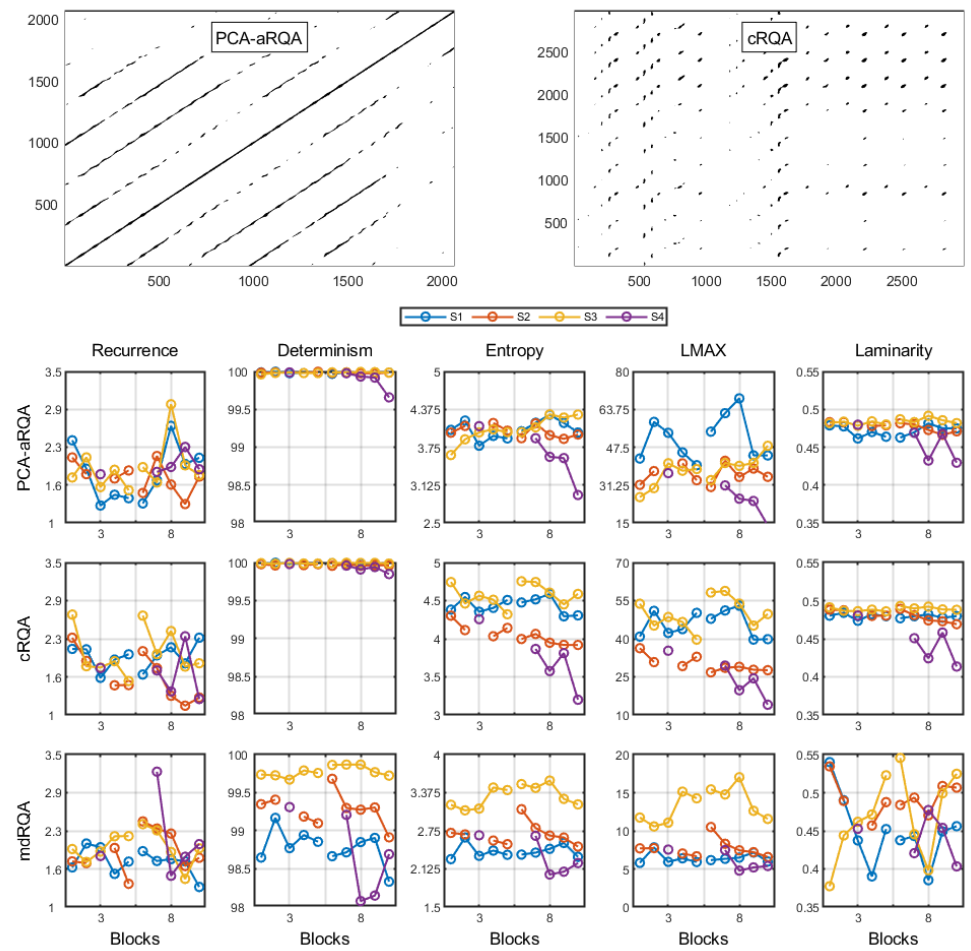
Figure 3. Recurrence plots (top row) and the recurrence quantification analyses (PCA-aRQA, cRQA, and mdRQA) outcomes for all four participants.